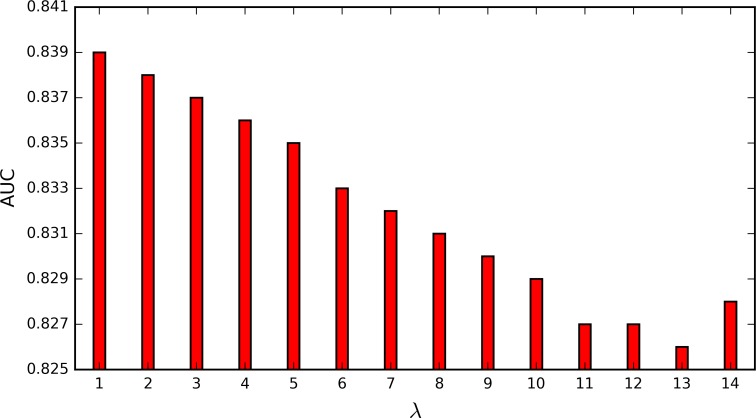
AUC scores of the PseDNC models with the variation of λ on Human dataset.